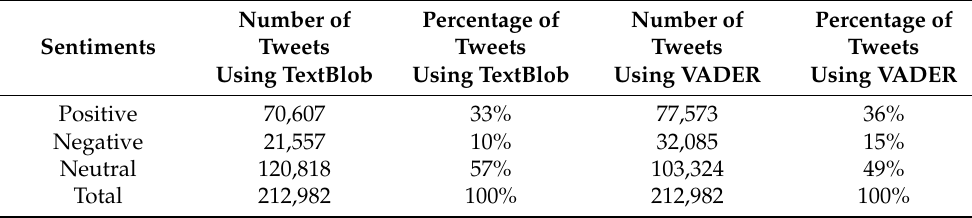
Table 2. The sentiment classification of tweets using TextBlob and VADER. Number of Percentage of Number of Percentage of Sentiments Tweets Tweets Tweets Tweets Using TextBlob Using TextBlob Using VADER Using VADER Positive 70,607 33% 77,573 Negative 21,557